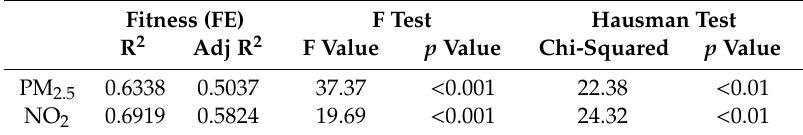
Table 2. Results of the fixed e ff ect (FE) model and individual e ff ect test. Fitness (FE) F Test